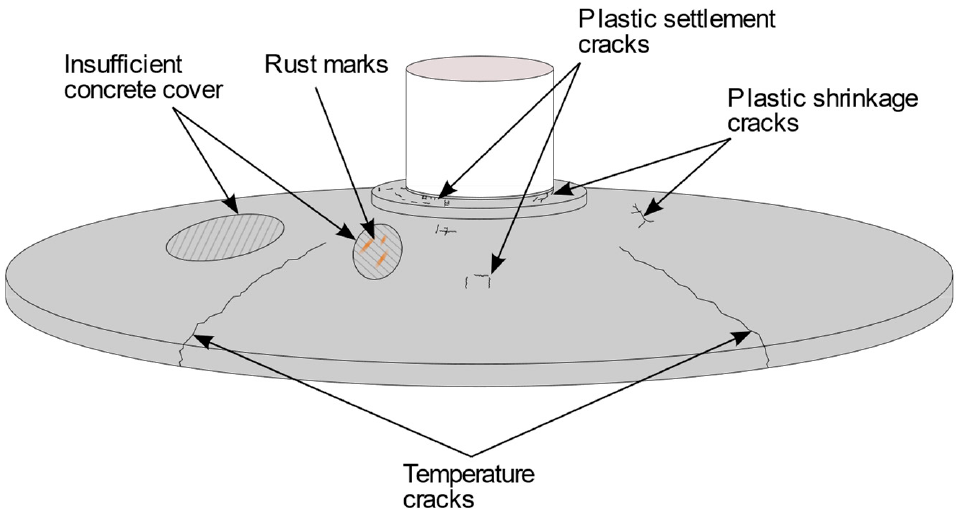
Figure 5. Sketch summarizing the different types of defects observed and some typical positions of the defects on the foundations (these defects were not all observed on a single foundation but on various